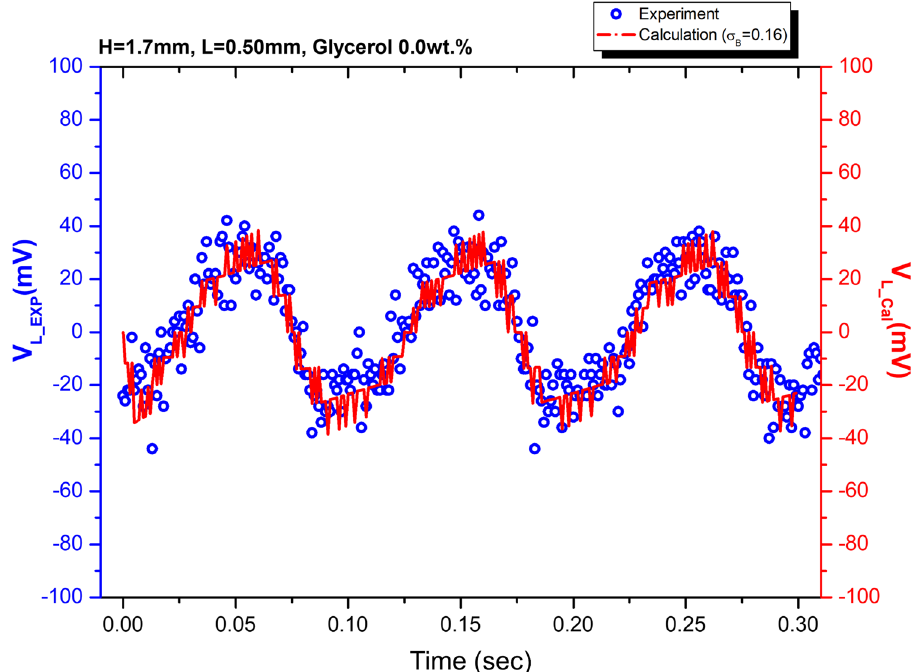
Figure 8. Experiment (blue circles) and numerical calculations (red curves) of voltage drop V L (t) through load resistor R L as a function of time with sinusoidal wave inputs at 10 Hz with a different amplitude of 0.50